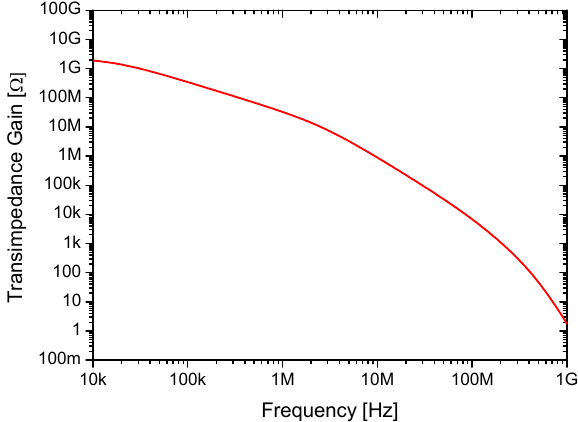
Figure 3. Transimpedance gain versus frequency of the sustaining amplifier circuit.